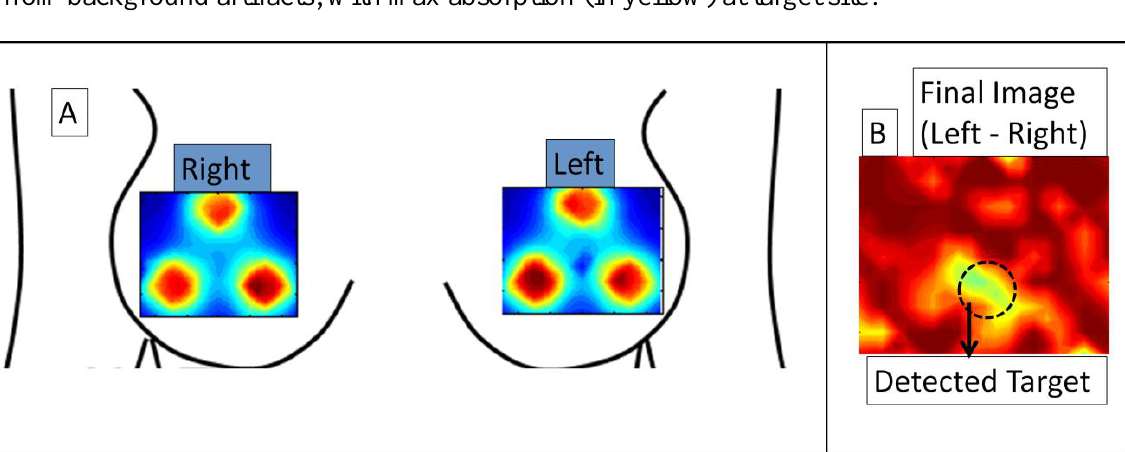
Figure 6. Simultaneous bilateral imaging using Gen-2 hand-held imager showing ( a ) 2D surface contour plot of intensity distribution on left and right breast ( b ) final subtracted image of left-right breast, in a normal breast with a 0.45 cc absorption target embedded under left breast flap at 6’o clock position. Final image in (b) differentiates target distinctly from background artifacts, with max absorption (in yellow) at target